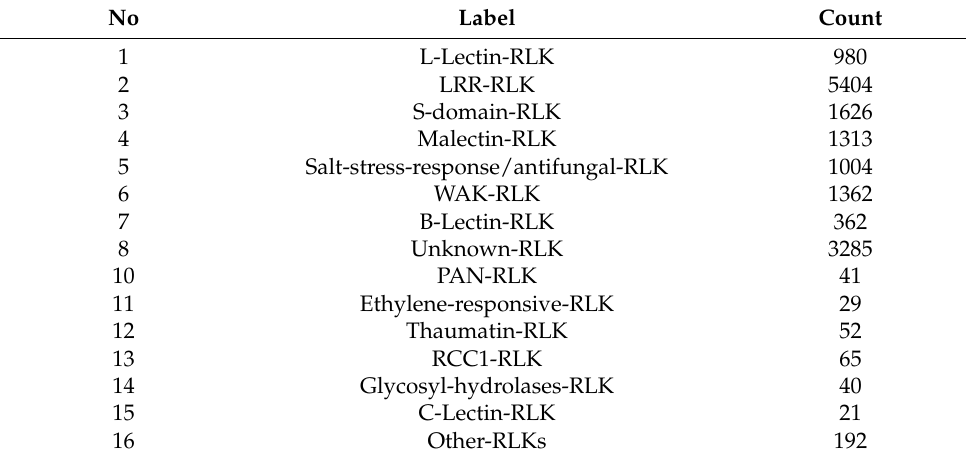
Table 2. Subfamily size of receptor-like kinase